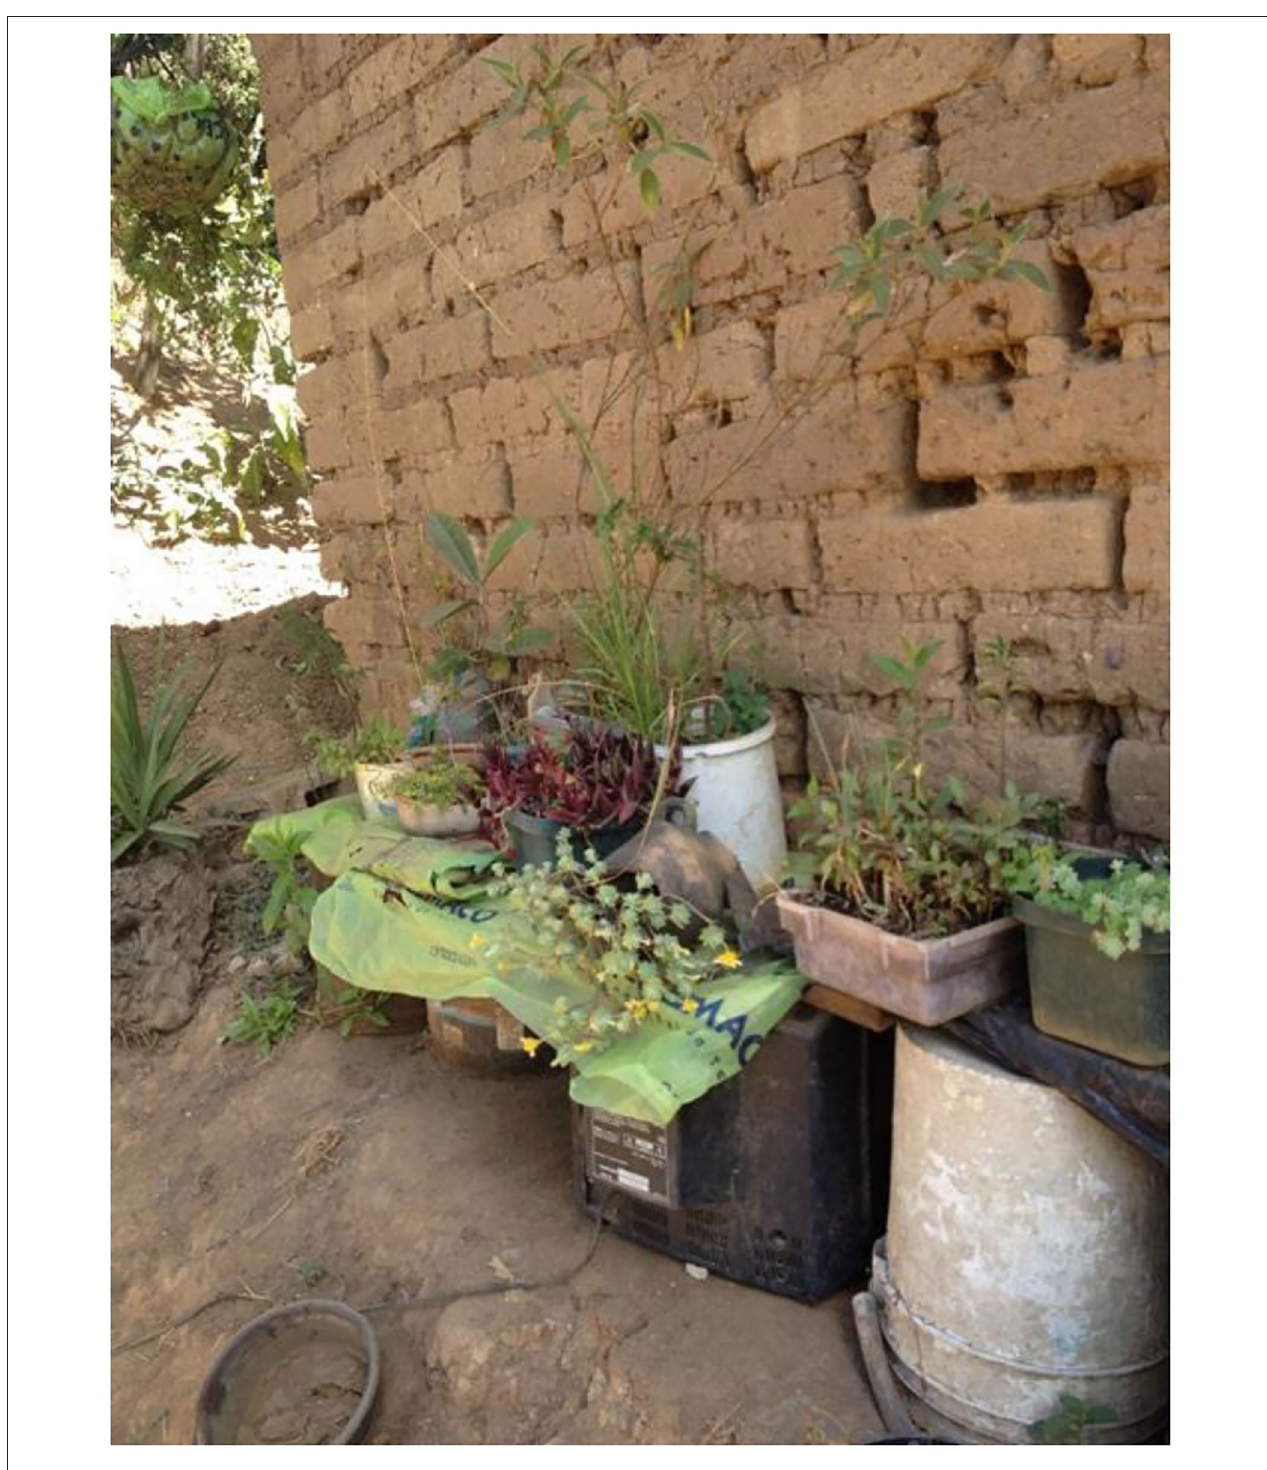
FIGURE 2 | Example of keeping household possessions for a different purpose. Source: Authors’ illustration. the Bible. The participants were all Catholics and believed in God frequently (Kates, 2001). The people mutually help one another and the scripture’s teachings. “My last piece of clothing, I gave as because the place where they live is quite small and everyone a present. I recognized I was not using it, and I did not want to knows all the others. The value of sharing is a key teaching of